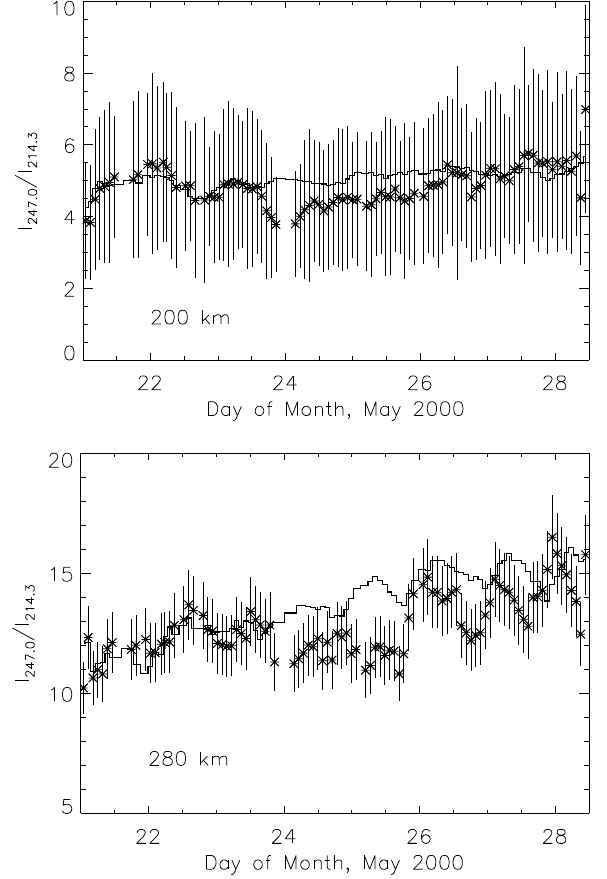
Fig. 5. Slices through Fig. 4 at 200km (top) and 280km (bottom). Solid line represents expected intensity ratio at this altitude using the neutral thermosphere provided by the MSIS model for the con- ditions on each day. The uncertainties due to the fitting and removal of nearby N 2 and NO molecular bands, which are brighter at lower altitudes, are reflected in the uncertainties in these line intensity ra- tios.